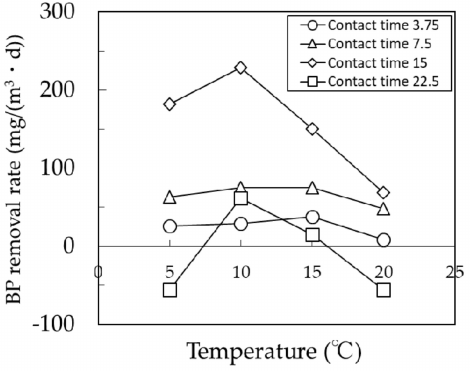
Figure 6. Effect of temperature on biopolymer (BP) removal rate in BCF.